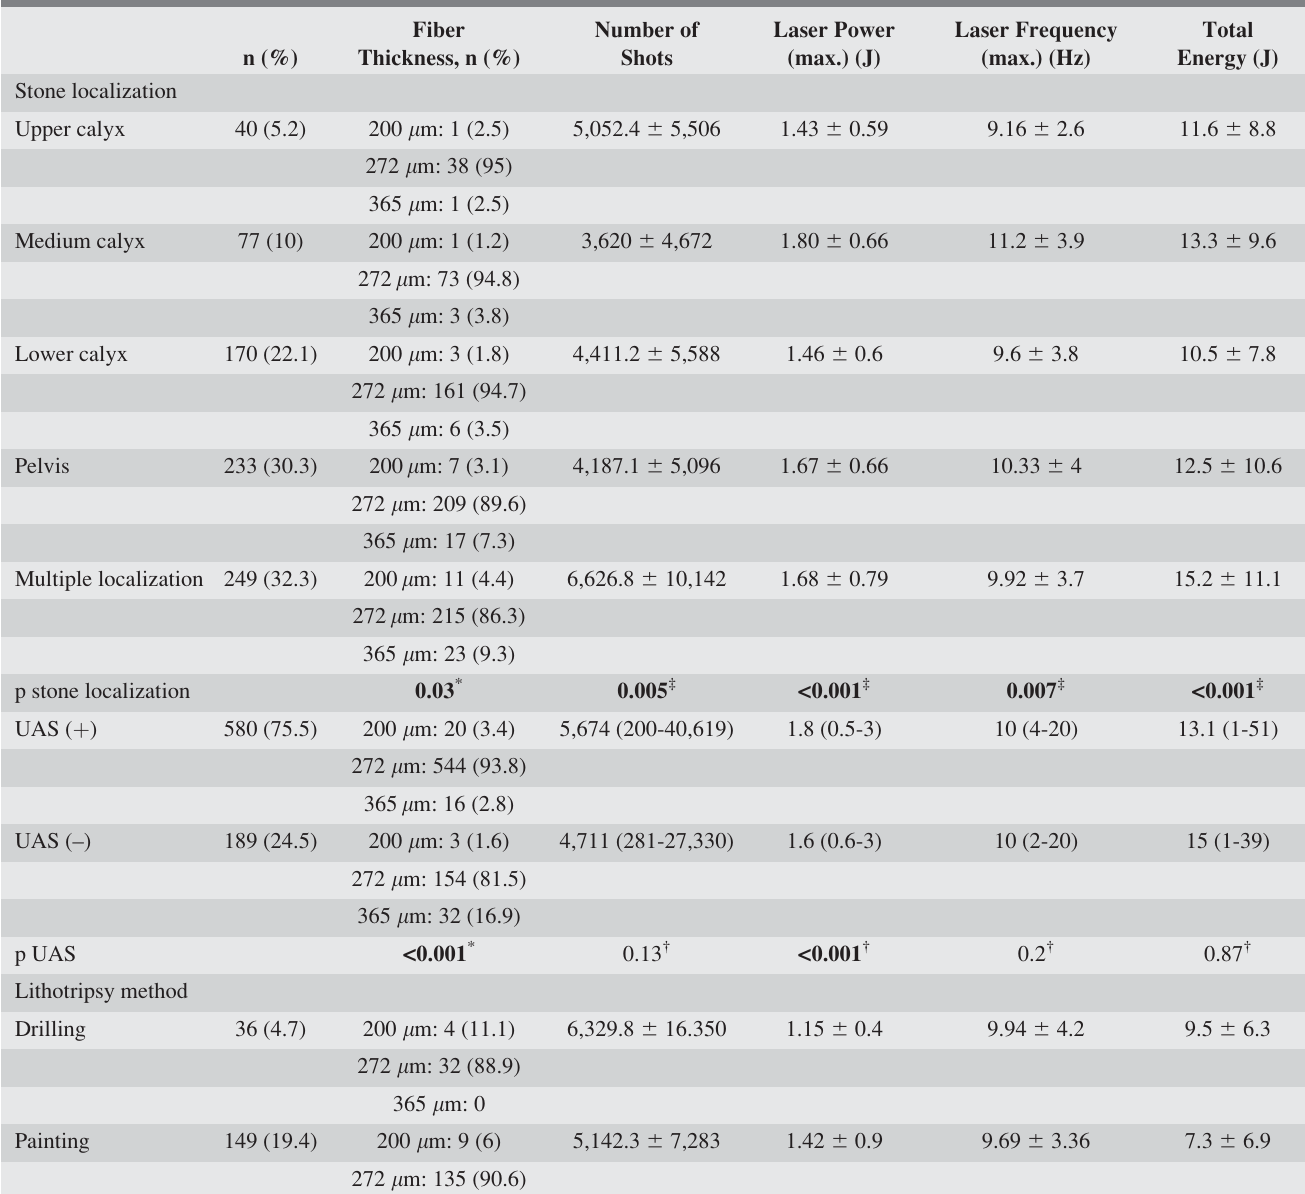
Table 4. Details of the Relationship between Laser Parameters and Stone Localization, UAS, Lithotripsy Method, PULS